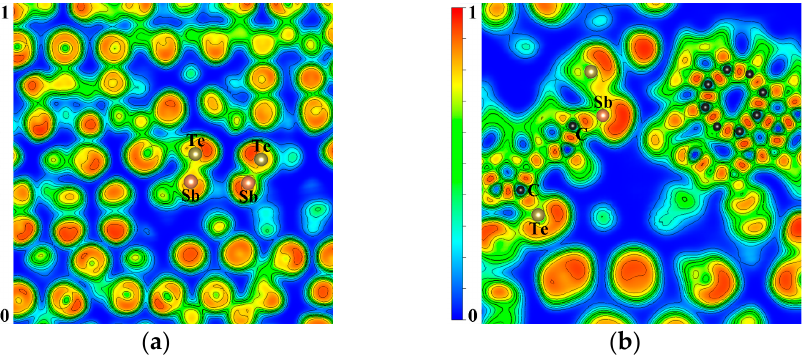
Figure 5. T he -COHP curve of Σ 3 twin boundary FCC-Sb 2 Te 3 . Figure 5. The -COHP curve of Σ 3 twin boundary FCC-Sb 2 Te 3 .